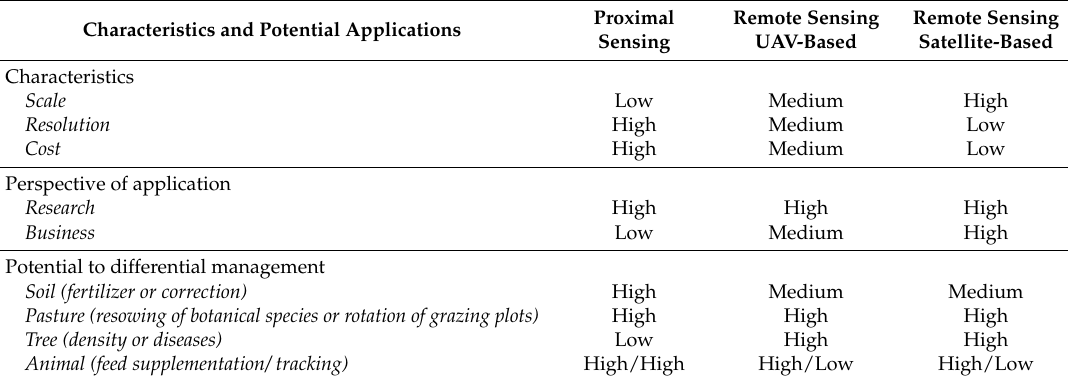
Table 2. Suitability of different sensing technologies for characterizing and to managing montado ecosystem: comparative analysis based on characteristics and potential